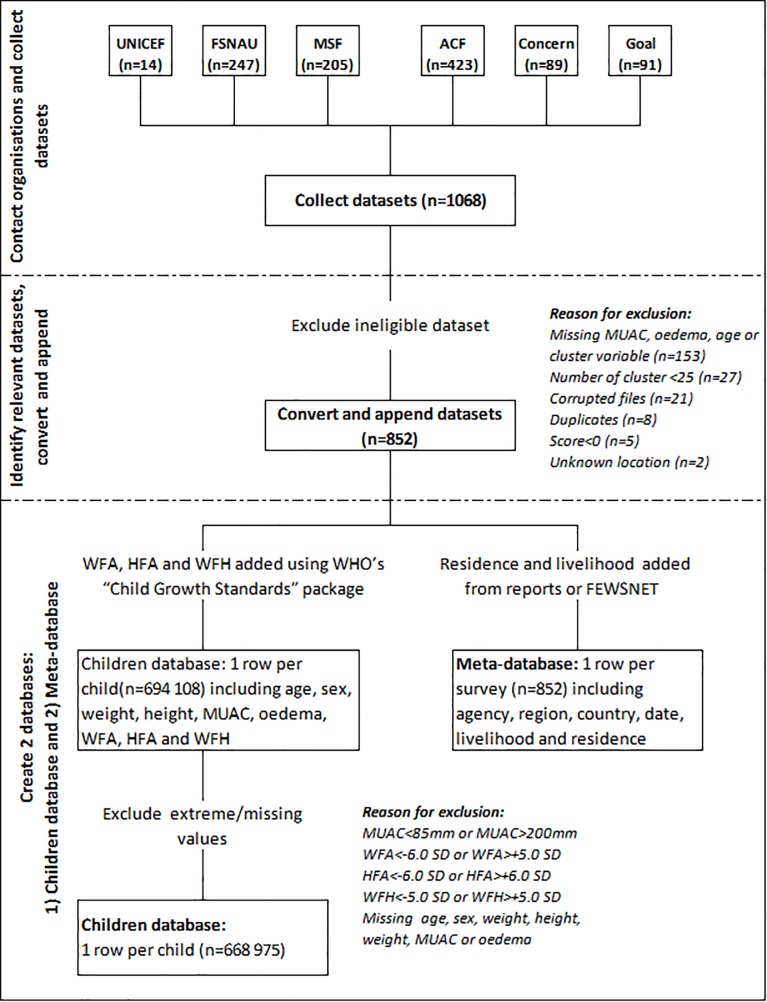
Data management.